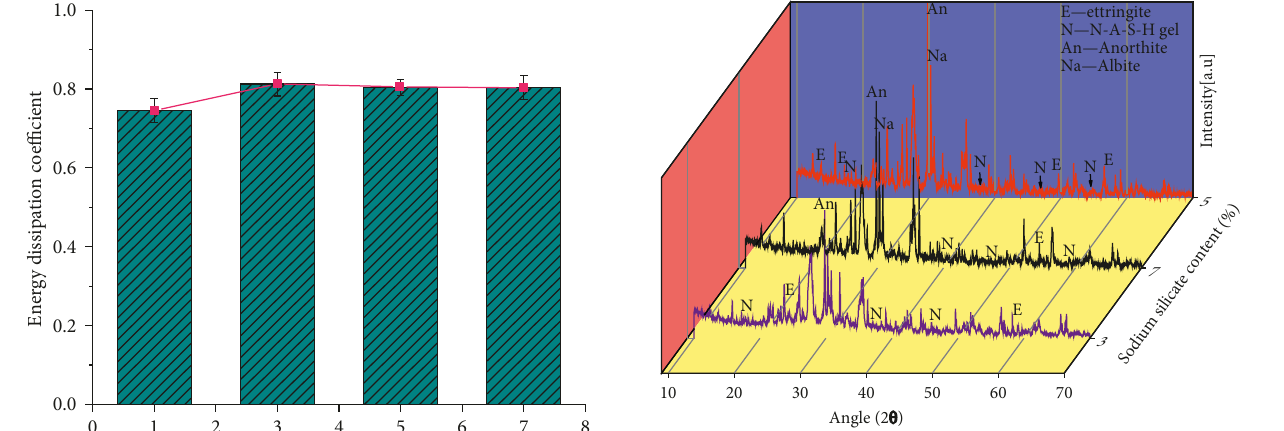
Figure 13: The XRD pattern of the lunar soil simulant with dif- ferent sodium silicate contents. Figure